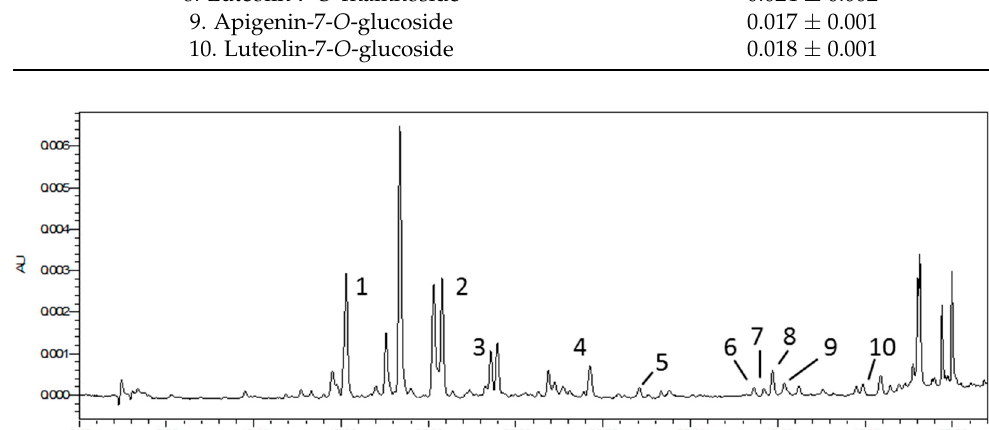
Figure 2. Chromatogram of black currant leaf extract with marked peaks of the identified compounds. The numbers 1–10 refer to the names of the compounds listed in Table 1.